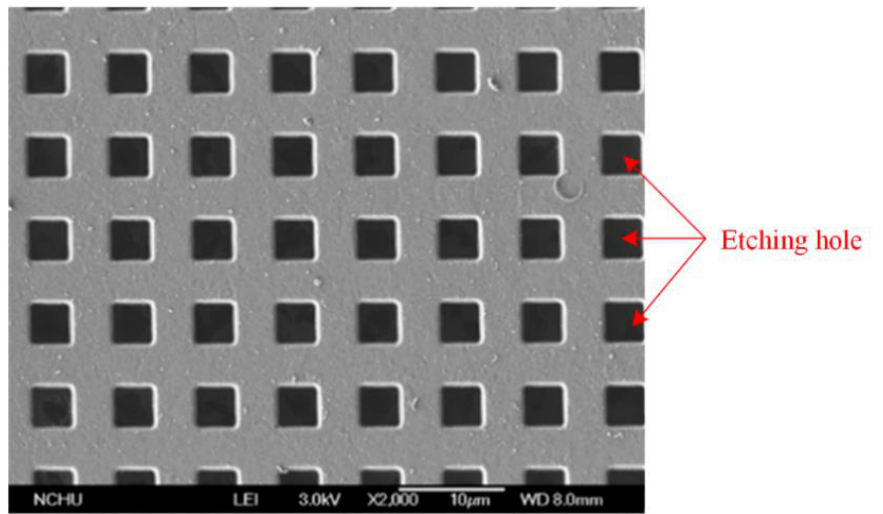
Figure 11. SEM picture of the membrane for the MSS.